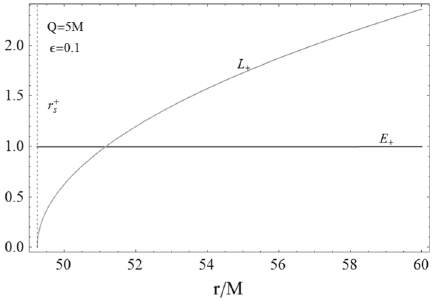
√ Fig. 23 Class :0 < (cid:2) < M / Q and Q > 9 / 8 M . Parameter choice is as follows: Q = 5 M and (cid:2) = 0 . 1. Then M / Q = 0 . 2 and r + s = √ Fig. 26 Class : M < Q ≤ 9 / 8 M and − M / Q < (cid:2) < 0. Parame- 49 . 2481 M .Circularorbitsexistwithangularmomentum L = L − ( gray curve ) and energy E = E − ( black curve ) in r > r + s and L = 0 at ter choice is as follows: Q = 1 . 06 M and (cid:2) = − 0 . 6. Then M / Q = r = r + s 0 . 943396, r − γ = 1 . 44708 M , r + γ = 1 . 55292 M , and r − s = 0 . 889152 M . Circular orbits exist with angular momentum L = L + ( gray curve ) and energy E = E + ( black curve ) in r − s < r < r − γ ( left plot ) and in r > r + γ ( right plot ). For r = r − s , L = 0